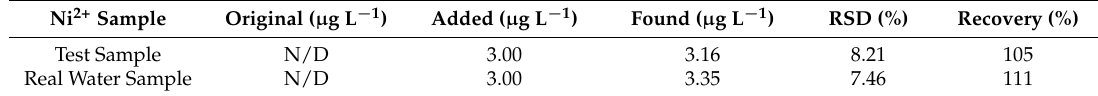
Table 3. Recovery studies of the NGr-DMG-GCE in test and tap water samples.